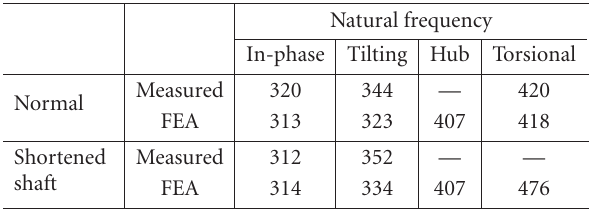
Table 5: Comparison of natural frequencies for normal shaft with those for shorten shaft.